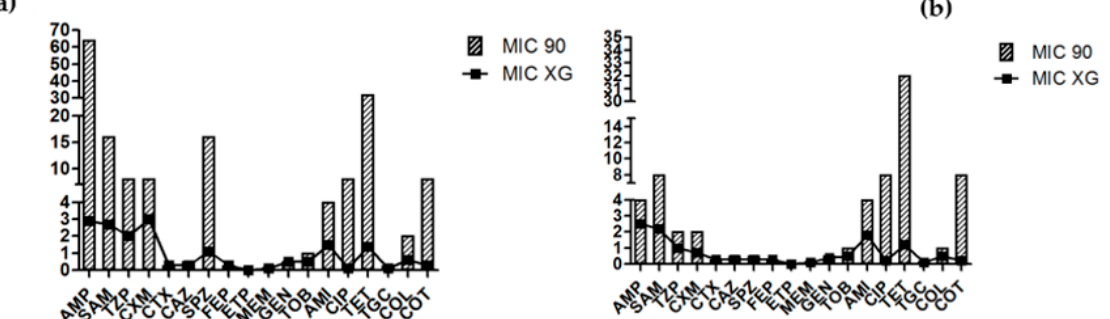
Figure 1. The values of MIC 90 and MIC XG (geometric mean MIC values of an antibiotic agent; mg/L) in E. coli of ( a ) healthy dogs and ( b ) dogs with diarrhea. Abbreviations: AMP = ampicillin; SAM = ampicillin + sulbactam; TZP = piperacillin + tazobactam; CXM = cefuroxime; CTX = cefotaxime; CAZ = ceftazidime; SPZ = cefoperazone + sulbactam; FEP = cefepime; ETP = ertapenem; MEM = meropenem; GEN = gentamicin; TOB = tobramycin; AMI = amikacin; CIP = ciprofloxacin; TET = tetracycline; TGC = tigecycline; COL = colistin and COT = trimethoprim + sulfonamide.